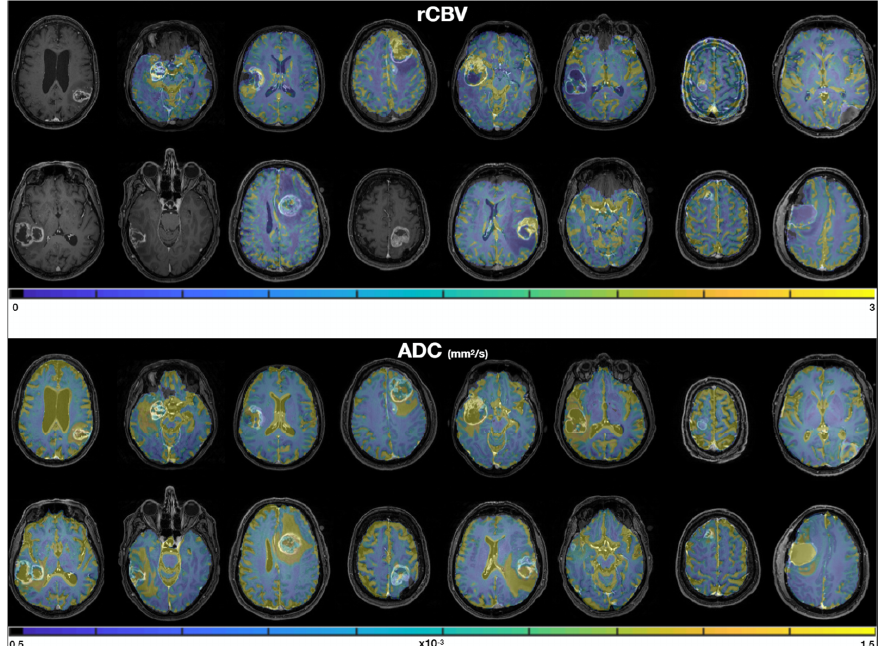
Figure 3. rCBV ( top ) and ADC ( bottom ) maps, overlayed on the T1 contrast-enhanced images. Masks of 2000 px were drawn in the two biopsy locations in order to extract median rCBV and ADC values for each sample. for each